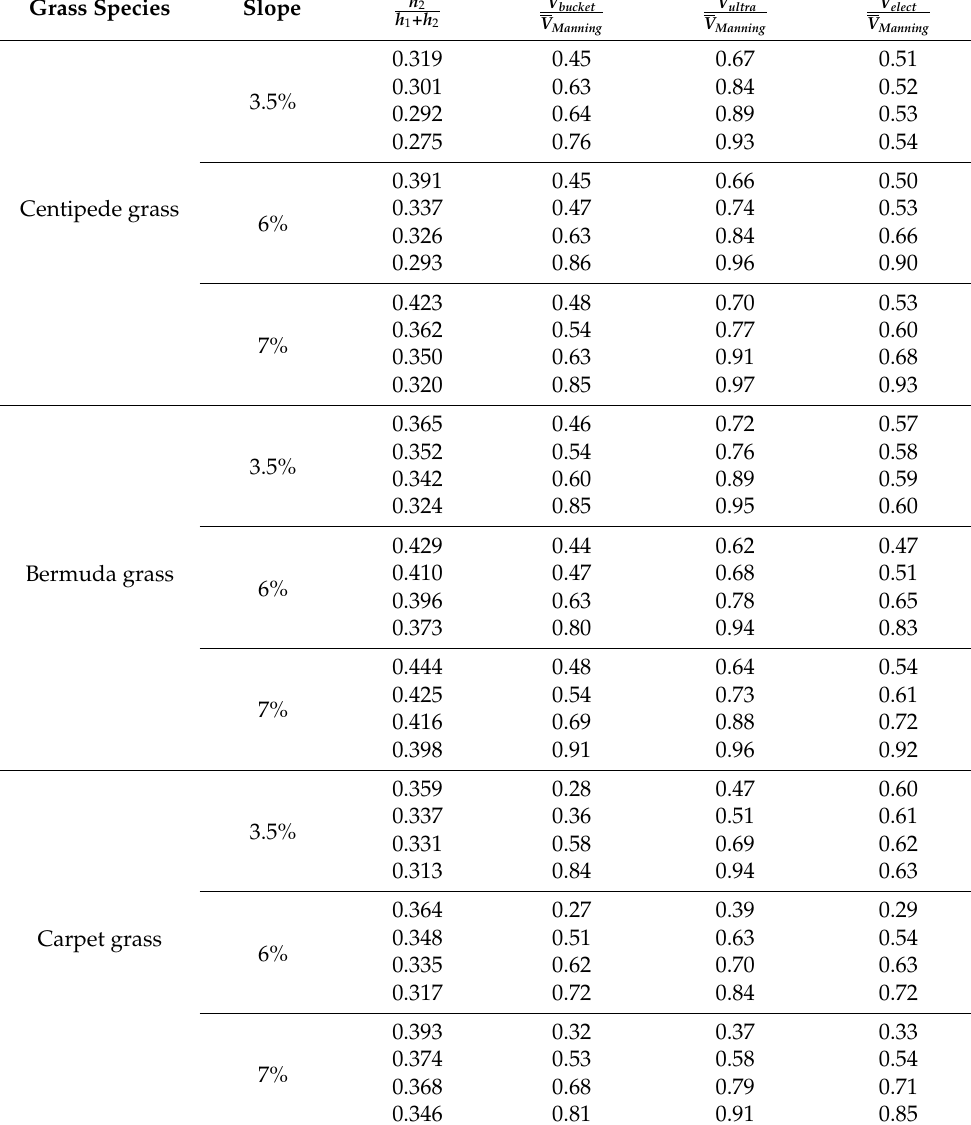
Table 4. Velocity ratios of measured values to Manning’s estimations.